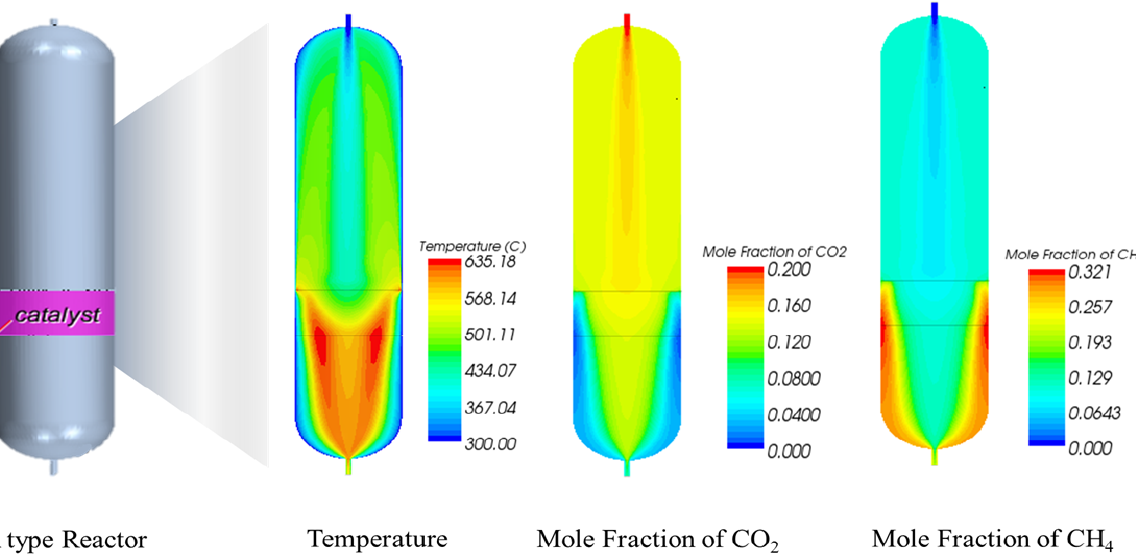
Figure 3. Reacting-flow simulation for the B-type reactor. 2.1.3. Flow Uniformity The uniformity index describes the distribution of a certain quantity on a surface. If the quantity is distributed equally, the resulting number is 1. This report is useful in ap- plications where a uniform flow rate is desired across an entire area. Heat exchangers, catalysts, and filters are examples of such applications. Therefore, flow uniformities were calculated on the surface immediately before the catalyst and at the center of the catalyst. Figure 4 shows the velocity profile and flow uniformity at the center of the upper section when the reactive gases reached the catalyst bed. The velocity profile at the center of the upper section, 5 cm away from the catalyst bed, indicated the maximum velocity at the center of the reactor, which increased subsequently because of the recirculating flow near